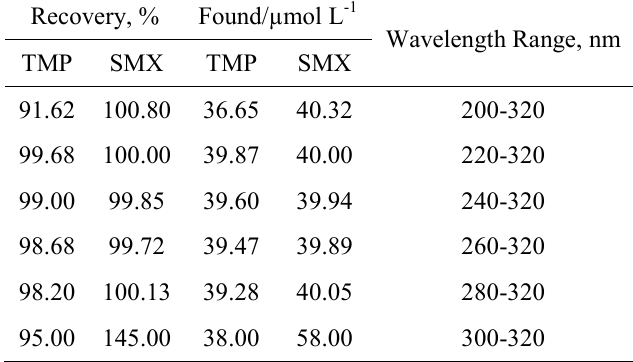
Table 1. Effect of scan wavelength range on the recovery of proposed method for 40 µmol L -1 of SMX and 40 µmol L -1 TMP